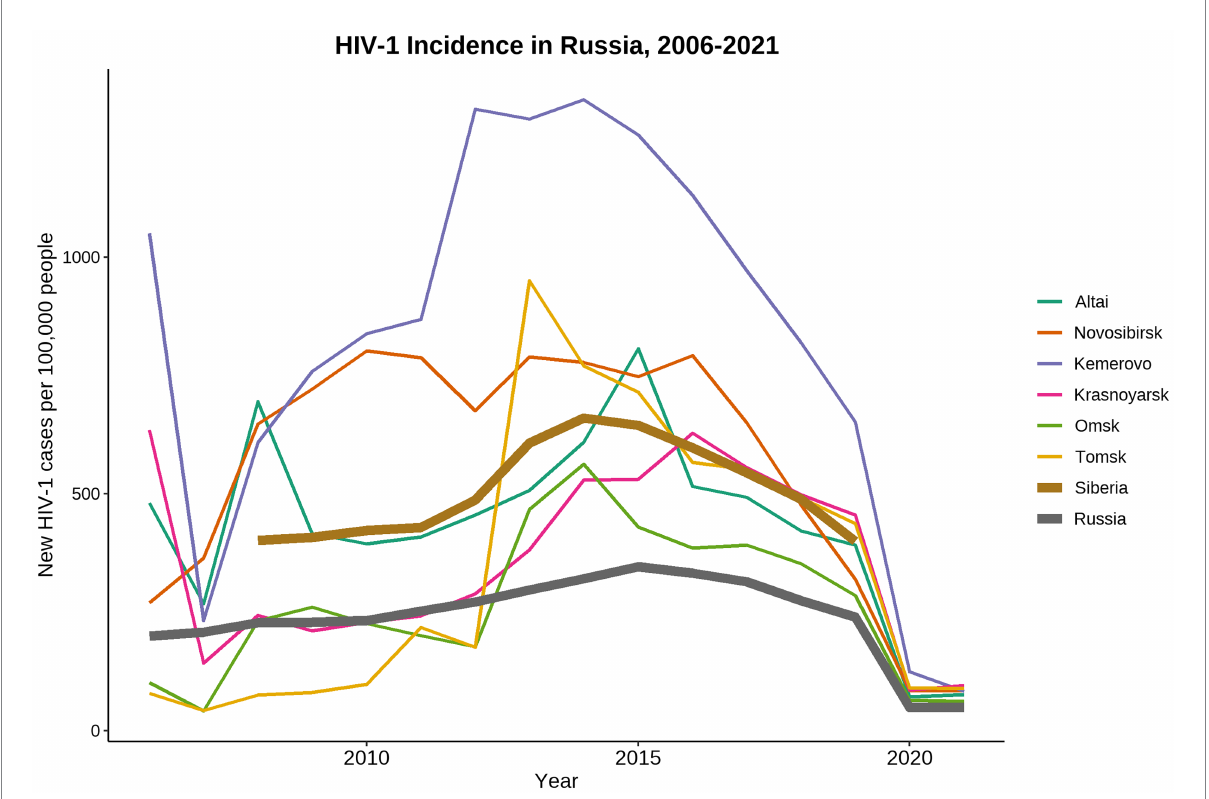
FIGURE 1 Dynamics of HIV-1 incidence in Russia from 2006 to 2021. Data were adopted from the Central Scientific Research Institute of Epidemiology of Rospotrebnadzor, Russian Federal AIDS Center, Moscow, Russia. Incidence data collected in 2019–2021 was most likely biased due to the COVID-19 world pandemic and represented the under-registered new HIV-1